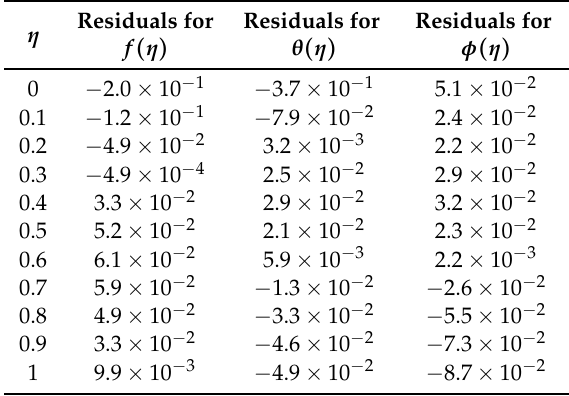
Table 5. Illustrates the residuals achieved by HAM for system of coupled differential equations forming in velocity, temperature and concentration